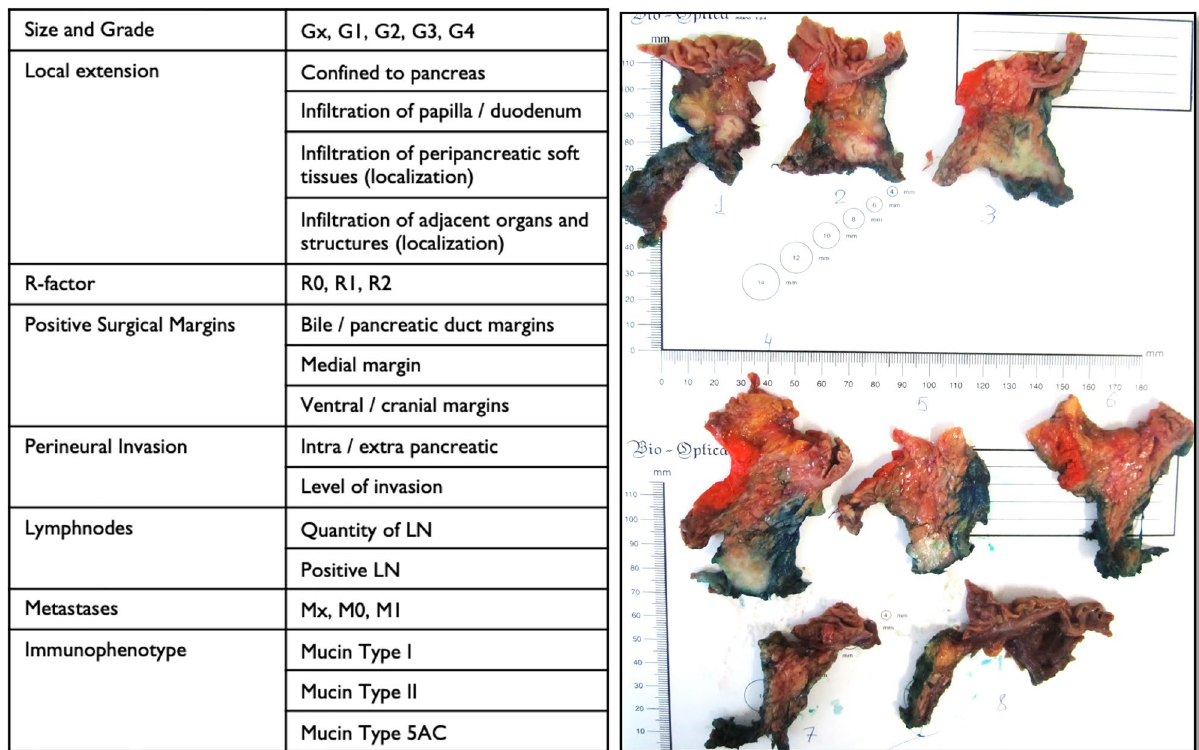
of a gastric type (Mucin Type 5AC expression). The tumor is located less than 1 mm from the medial resection margin and infiltrates the parapancreatic tissues (R1). Stage IIB, pT3 pN1 cM0. Slice thickness of the specimen 0.5 cm, EPNI was reported to be present in the first 4